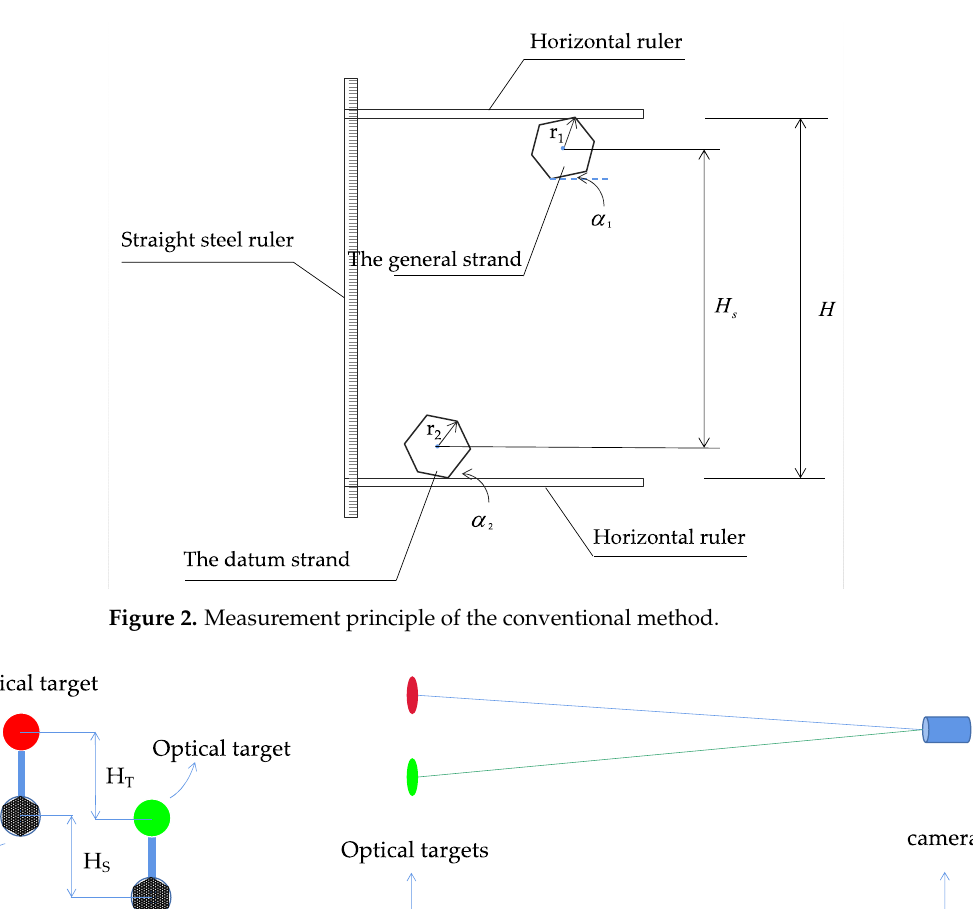
Figure 2. Measurement principle of the conventional method.